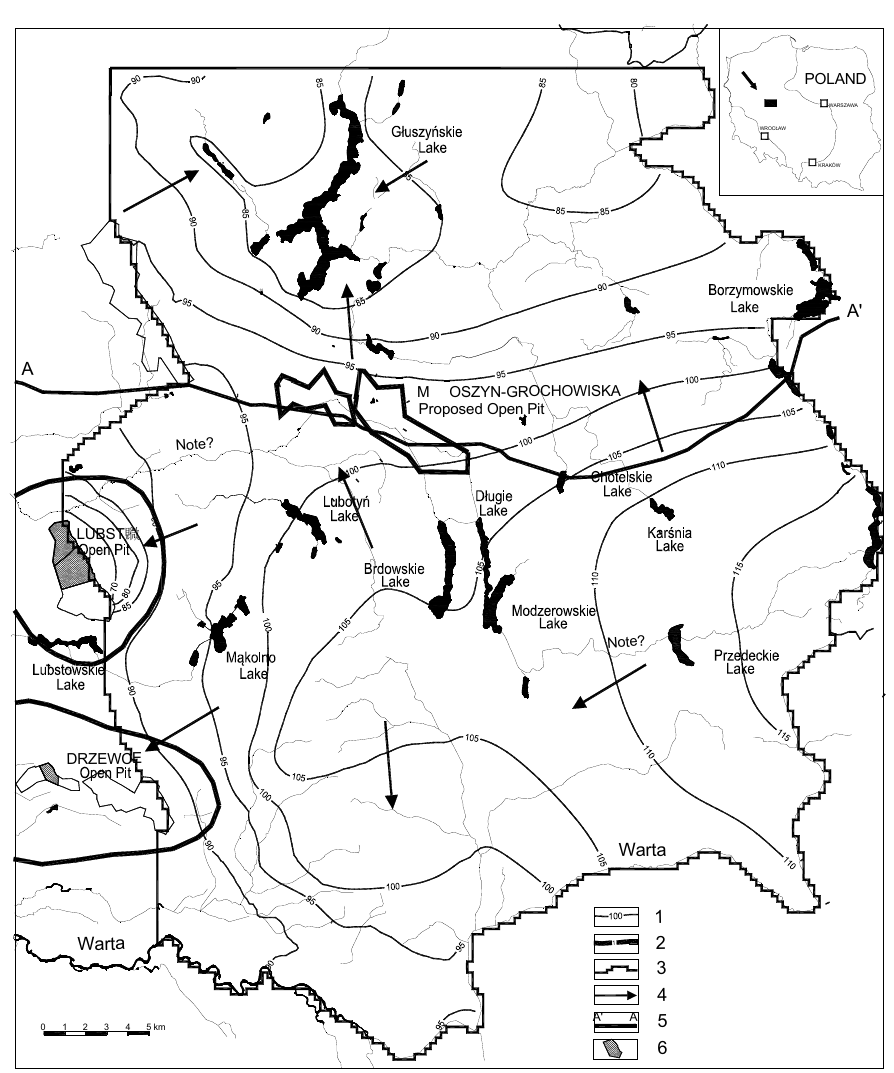
Figure 7. Groundwater flow modeling study for the proposed M ˛akoszyn-Grochowiska open pit in